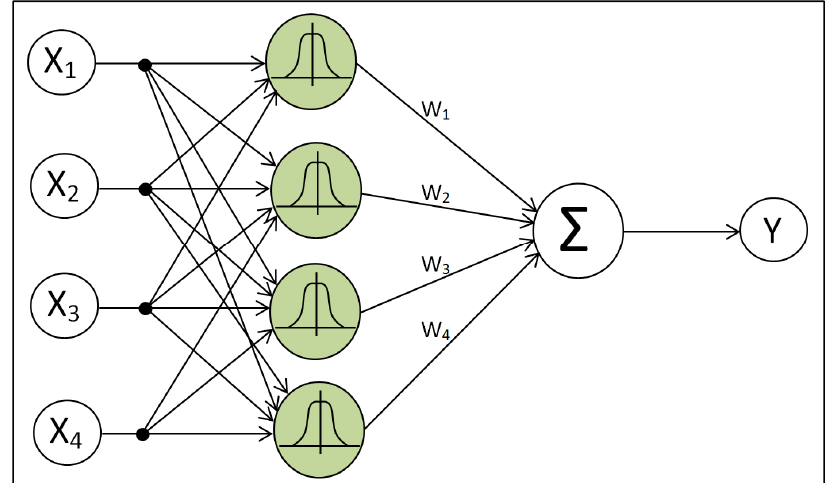
Figure 3. RBF architecture [39]. Water 2022 , 14 , x FOR PEER REVIEW